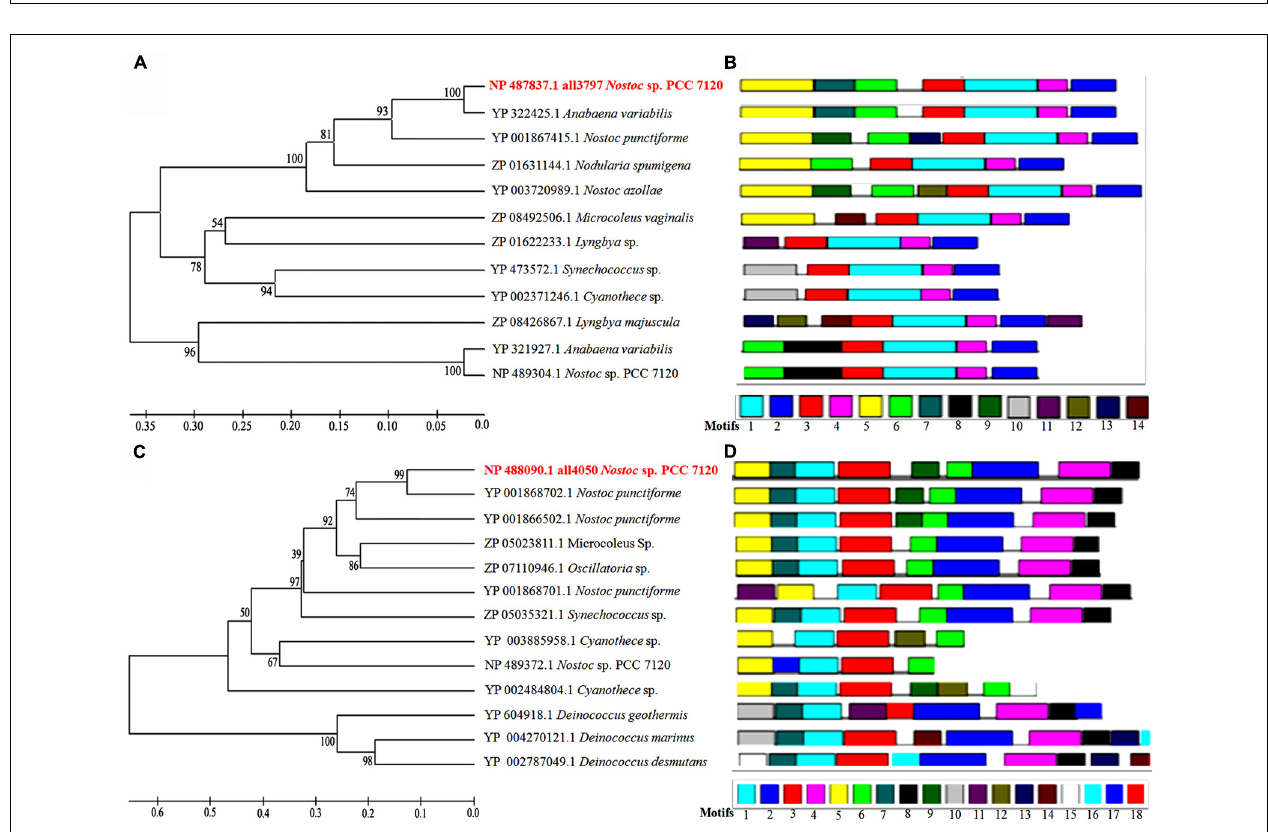
FIGURE 5 | Phylogenetic tree showing homology with proteins of other species of cyanobacteria and bacteria available in the database . (A) -phyologenetic tree, and (B) -motif analysis of all3797; (C) -phyologenetic tree, and (D) -motif analysis of all4050 (http://www.icp.ucl.ac.be/ ∼ opperd/ private/upgma.html) and MEME tool (http://meme.nbcr.net/meme/).